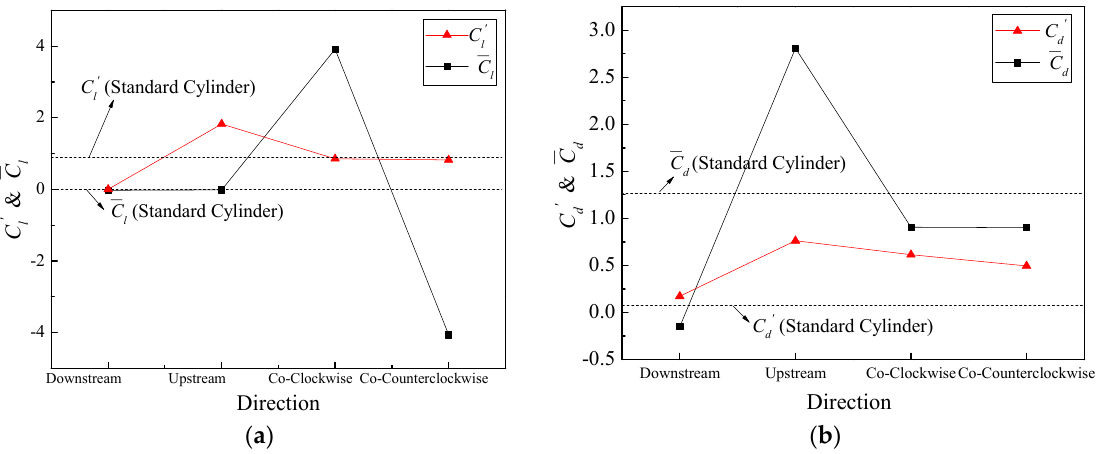
Figure 6. Characteristic values of lift and drag coefficient for different propagation directions. ( a ) C (cid:48) & C l . ( b ) C (cid:48) & C d l d